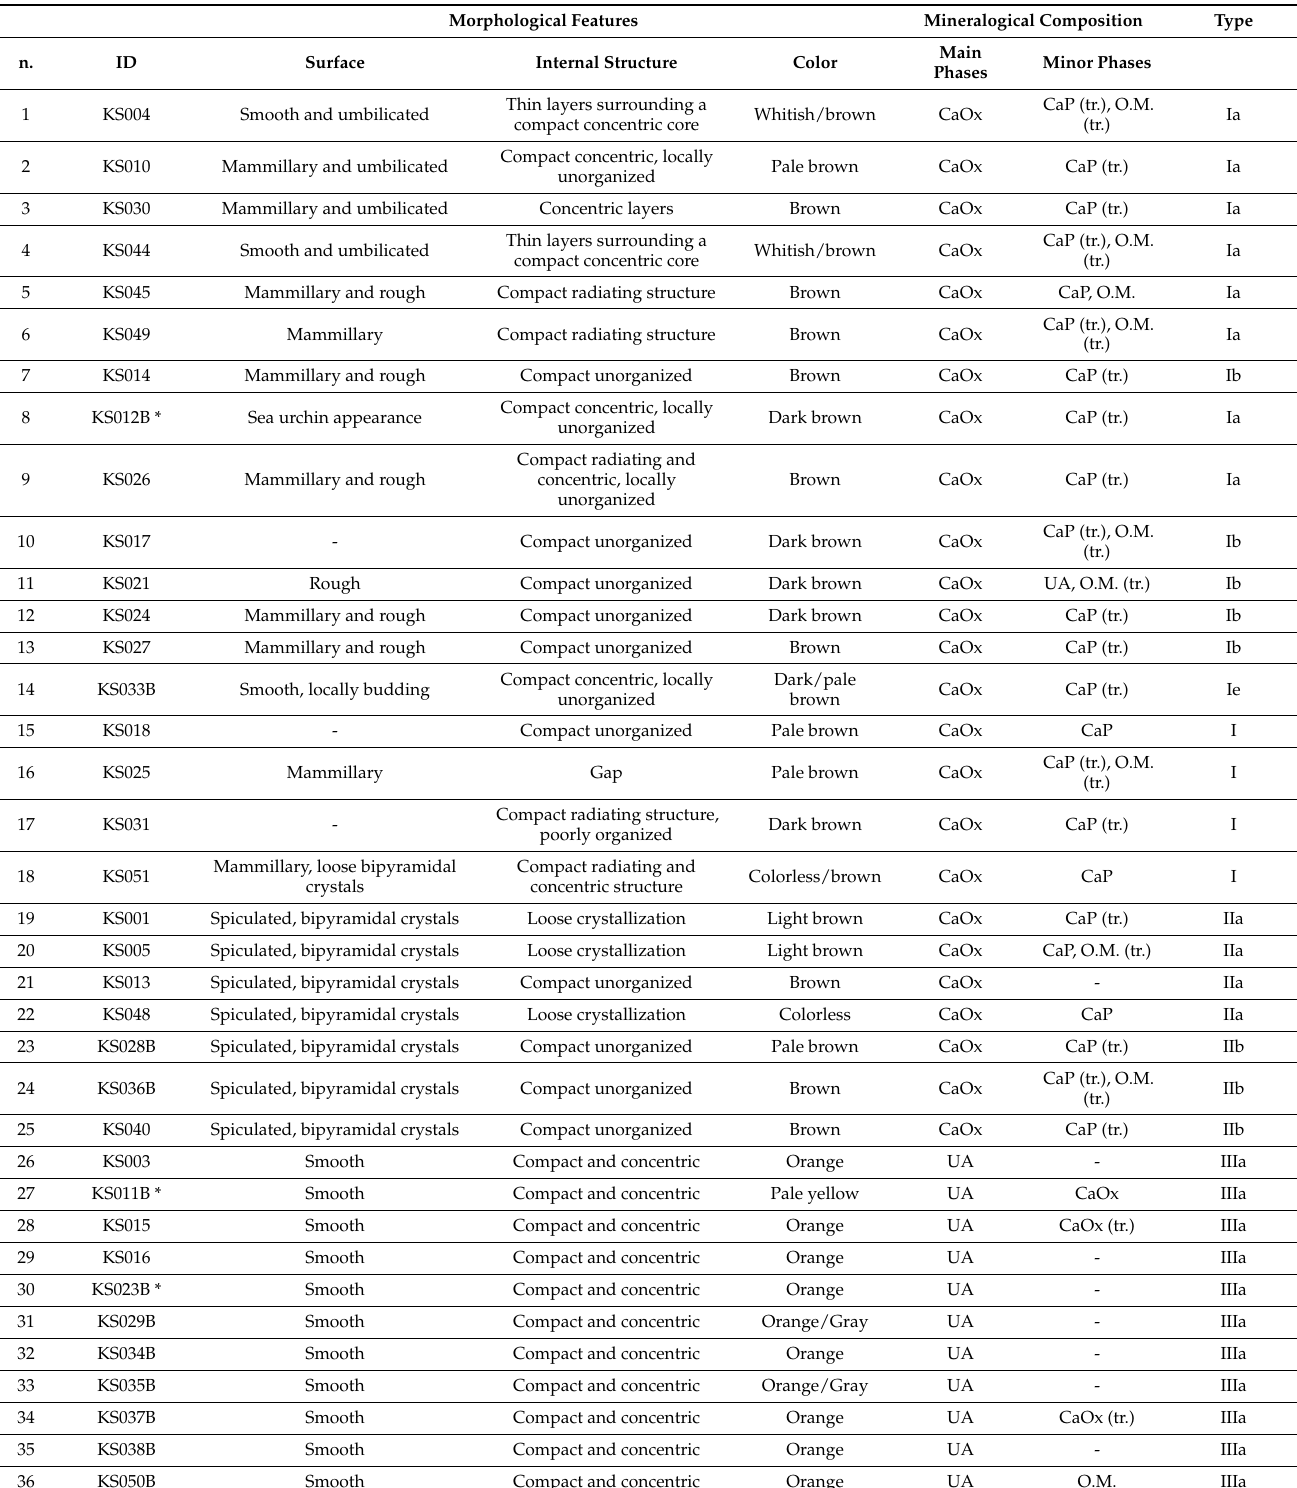
Table 2. Morpho-constitutional classification of human urinary stones from San Pio Hospital (Ben- evento, Italy). * From [11]; O.M., amorphous organic matter; UA, uric acid; AU, ammonium urate; tr.,